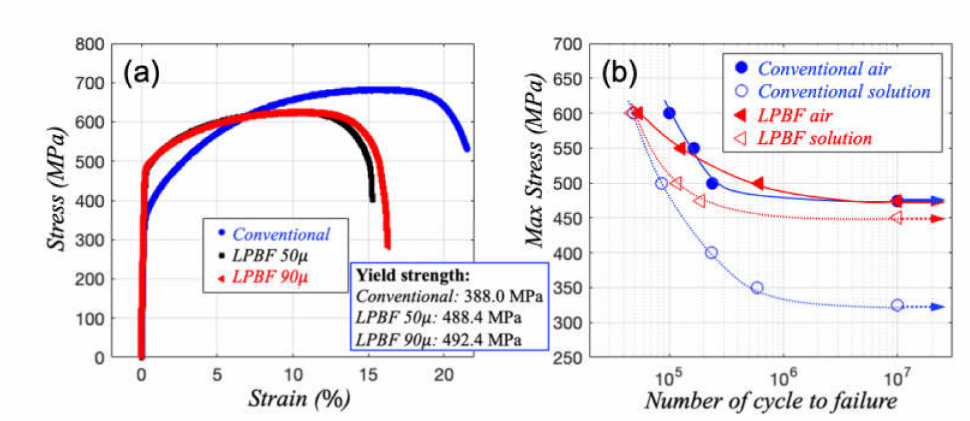
Figure 4. ( a ) Stress–strain relationship obtained through tensile loading test, and ( b ) high cycle fatigue life of smooth specimens of conventional and LPBF 316L SS printed at P = 195 W. Symbols with horizontal arrows in high cycle fatigue indicate that corrosion fatigue failure has not occurred after 10 7 load